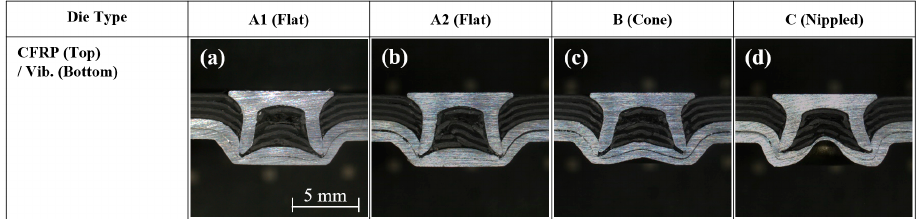
Figure 10. Cross-sectional images for the self-piercing riveted joint formed between vibration-damping steel and CFRP with respect to the die types: ( a ) die type A1, ( b ) die type A2, ( c ) die type B, and ( d ) die type C.